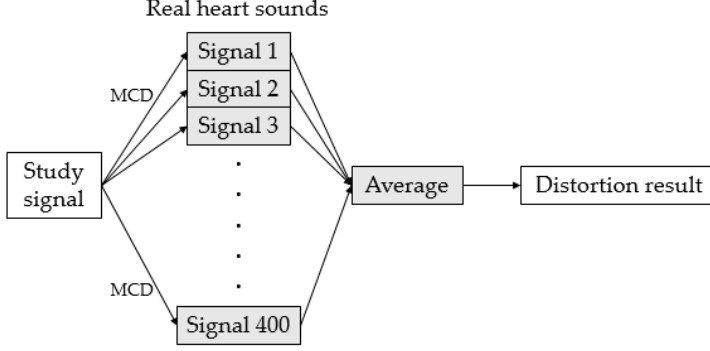
Figure 10. General diagram of the procedure to calculate the signal distortion.